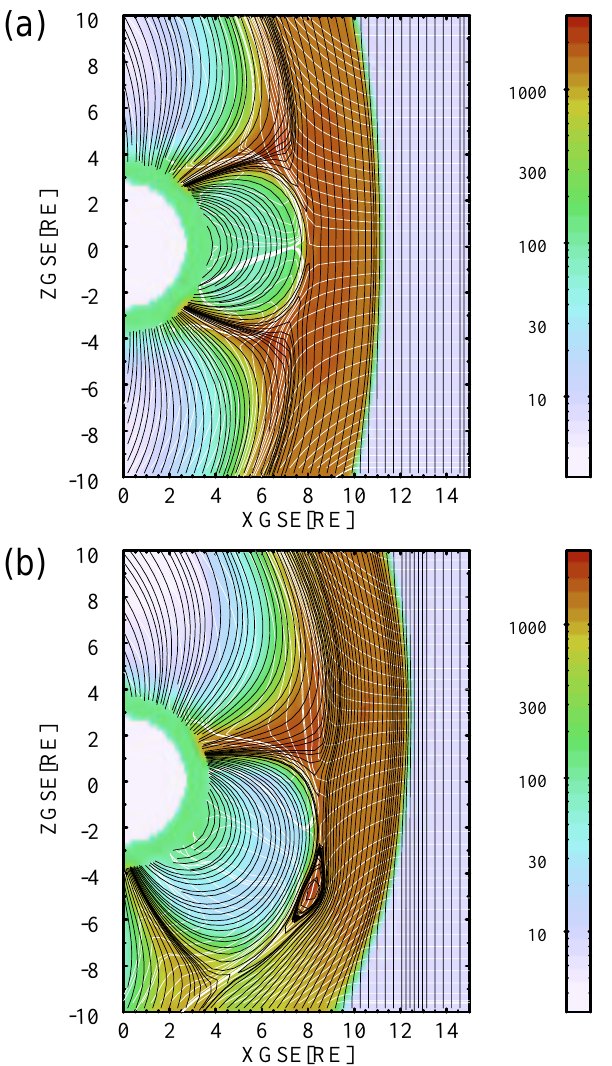
Fig. 1. (a) High-resolution simulation without dipole tilt. There is symmetry between the flow field and the magnetic field, leading to steady reconnection. (b) Same as (a), but with maximum (34 ◦ ) dipole tilt. There are multiple X-lines that lead to the formation of FTEs. The color represents the plasma pressure.